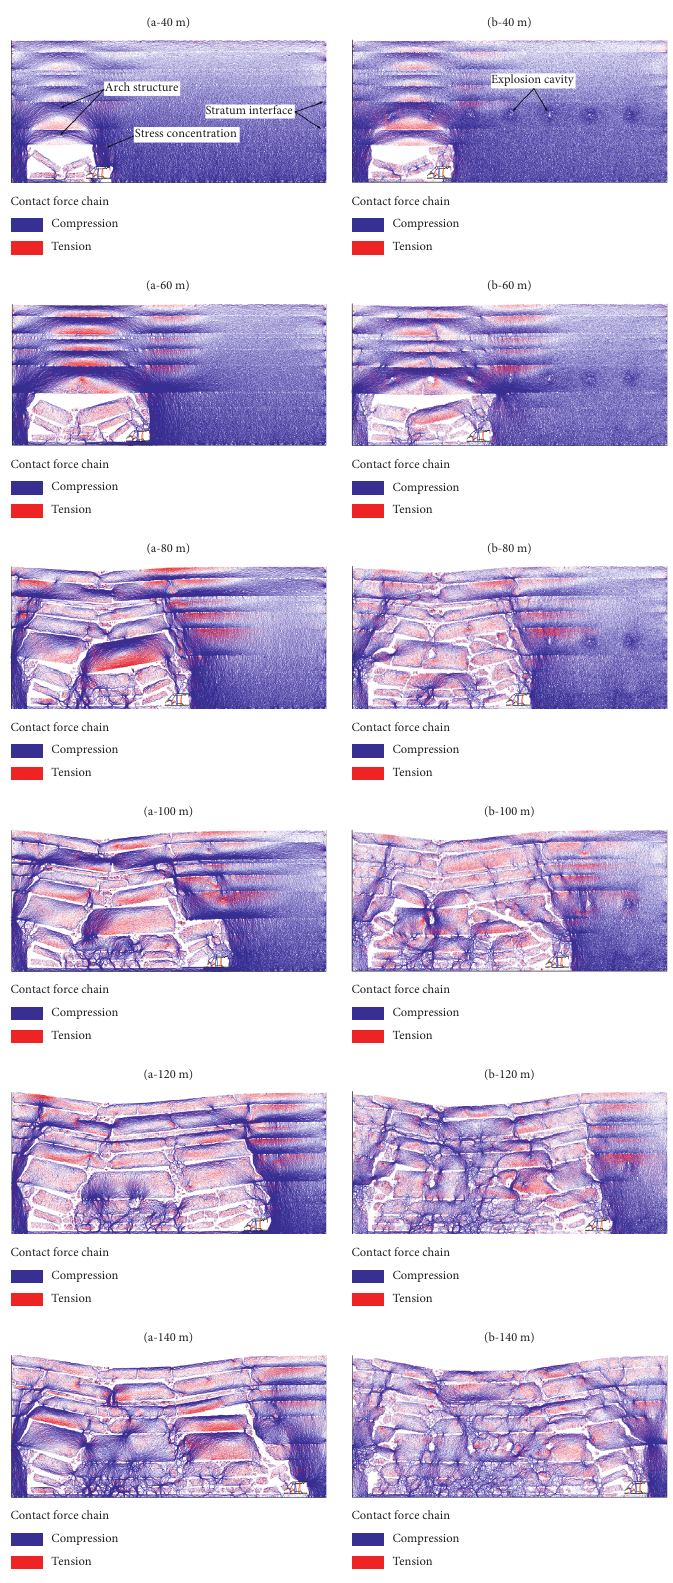
Figure 10: Development of force chains during the advancement of the working